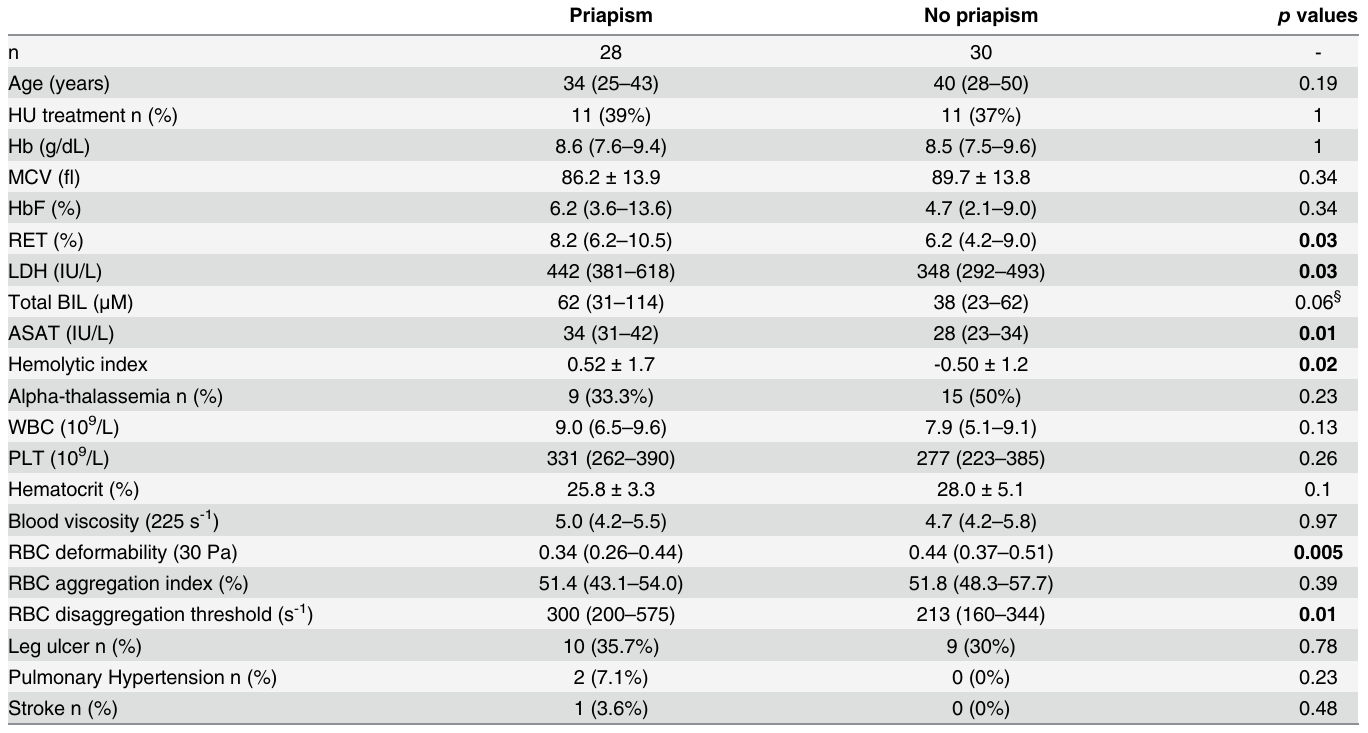
Quantitative variables were summarized as median with the interquartile range (IQR) or as means ± standard deviation. Qualitative variables are described by number and percent. Intergroup differences were assessed using Mann Whitney test, chi-square test, or unpaired Student ’ s t-test as appropriate. Signi fi cant p values are in bold.